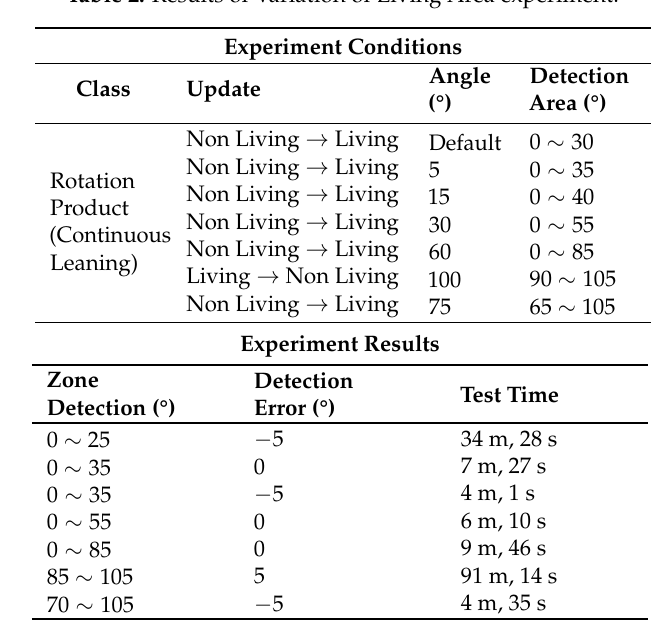
Table 2. Results of Variation of Living Area